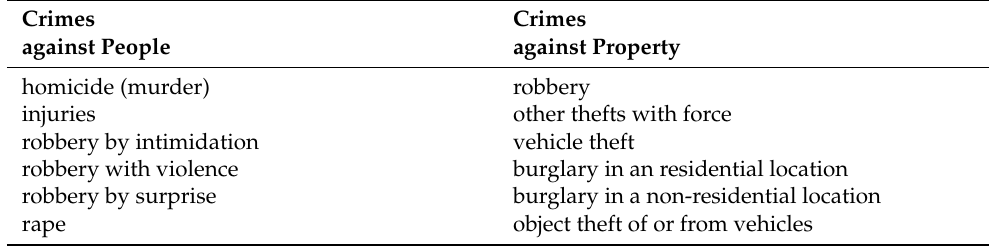
Table 4. Classification of